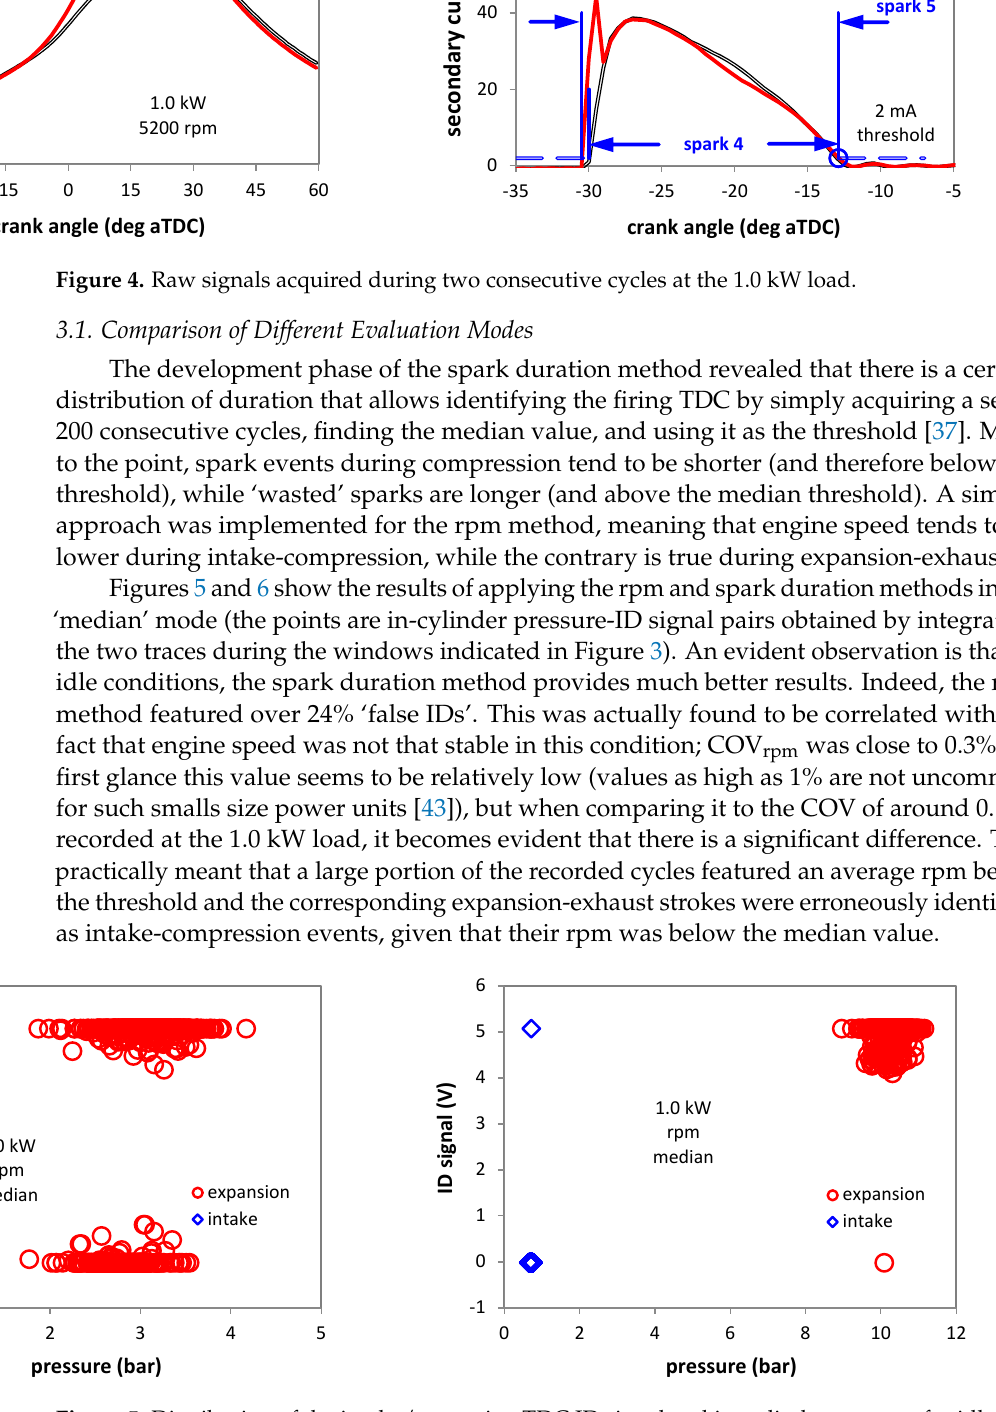
Figure 4. Raw signals acquired during two consecutive cycles at the 1.0 kW load.